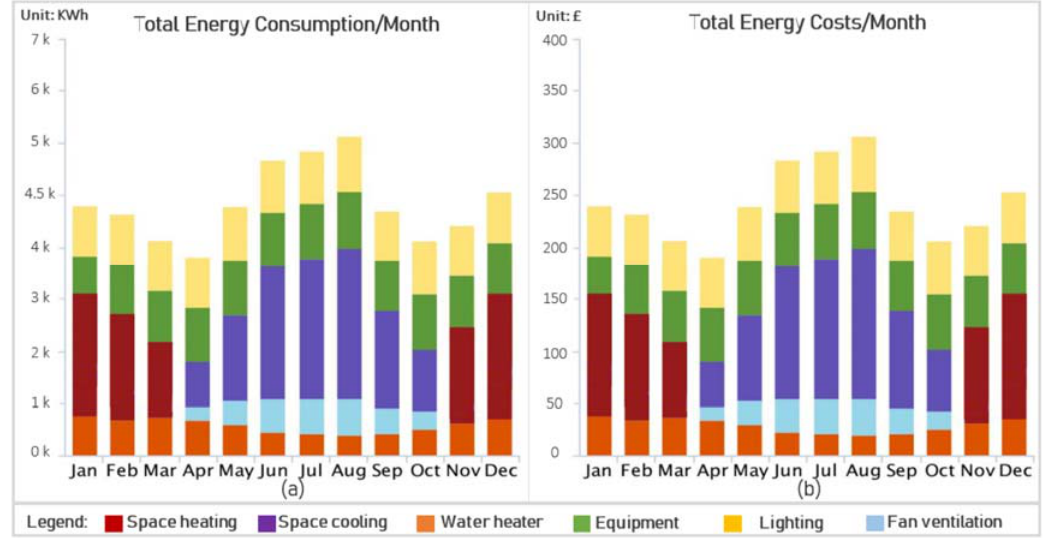
Figure 11. Standard Housing Unit: ( a ) Energy Consumption Analysis per Month, ( b ) Energy Costs per Month.